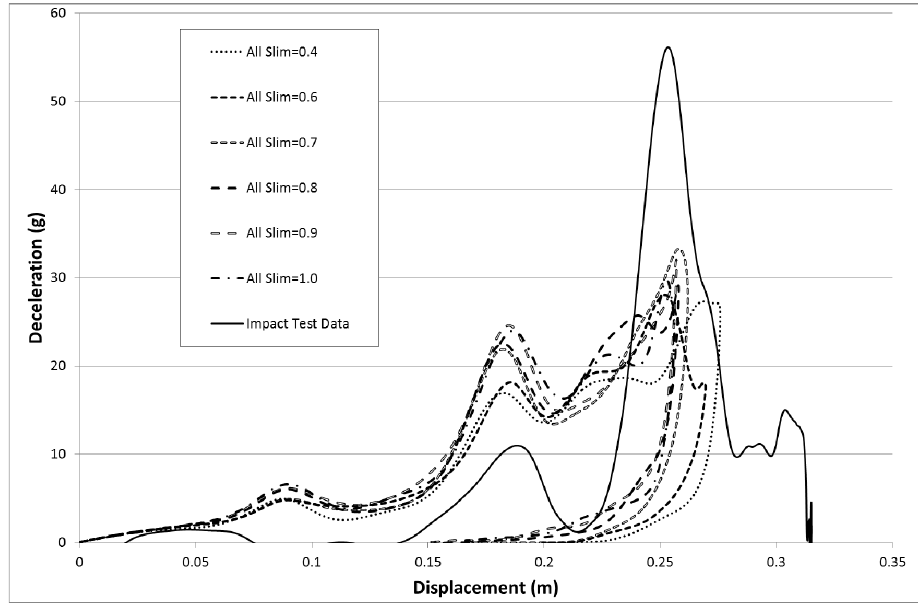
Figure 23. E ff ect of Slim factors with TSize = 0.0, Erods = 0.0, Soft = 0.0 and FS = − 1.0. Figure 23. Effect of Slim factors with TSize = 0.0, Erods = 0.0, Soft = 0.0 and FS = −